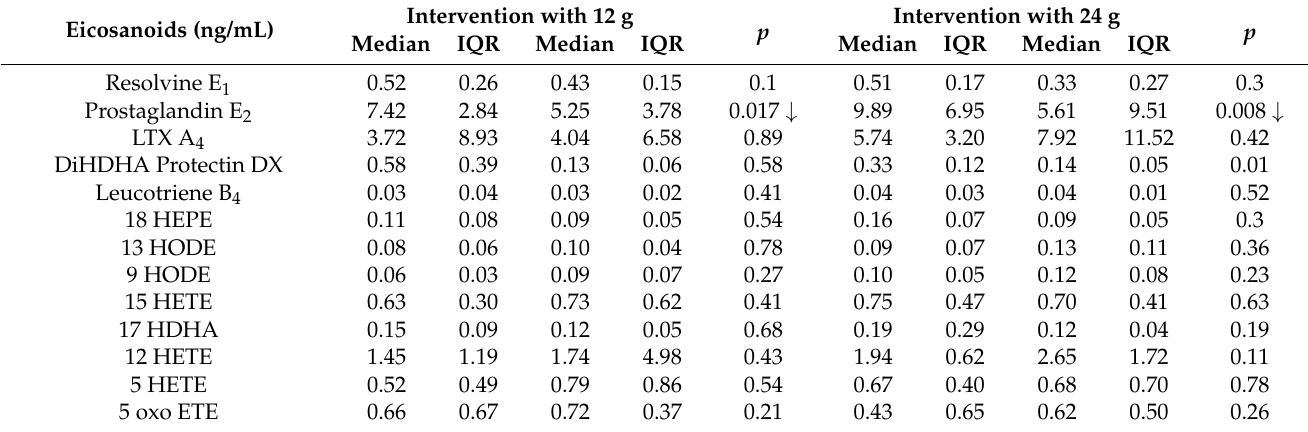
Table 3. Eicosanoids profile before and after 8 weeks of high-fiber buns